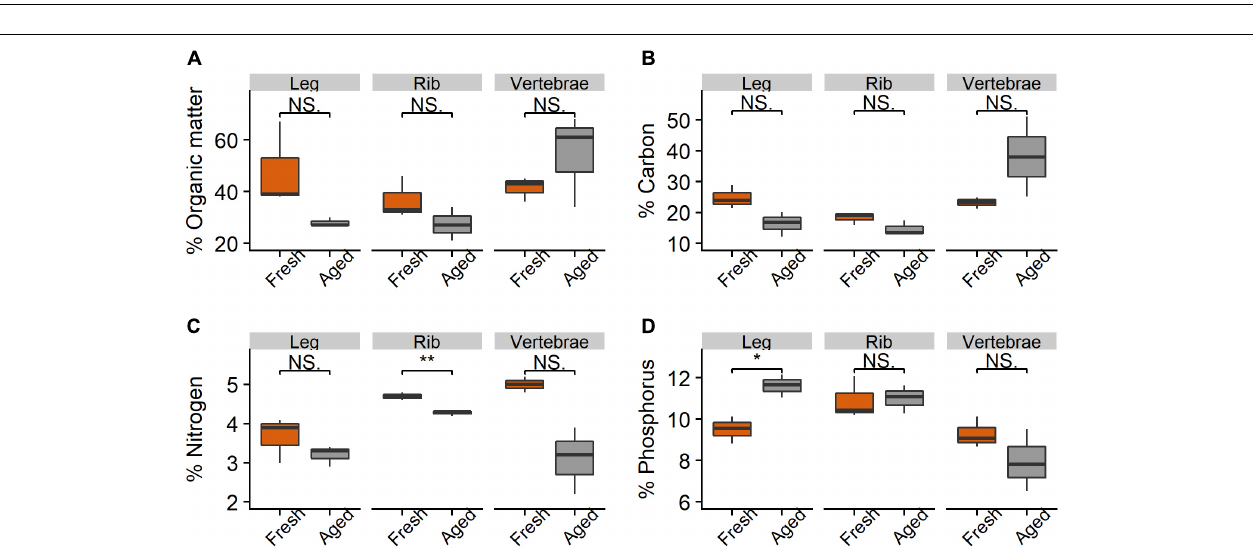
FIGURE 3 | Mean ( ± SE) proportion of biomass remaining for scapula, leg, rib, and vertebrae bones ( n = 3 per bone type) from a wildebeest carcass during litterbag deployment in the Mara River with best fit models following a parallel discrete model of decomposition.